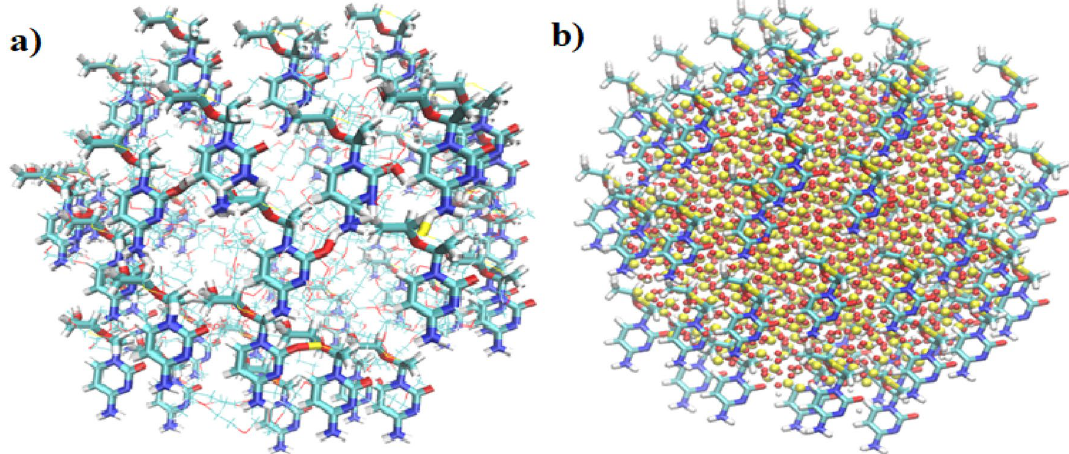
Figure 13. 48 drug molecules on ( a ) PEG and ( b ) SiO 2